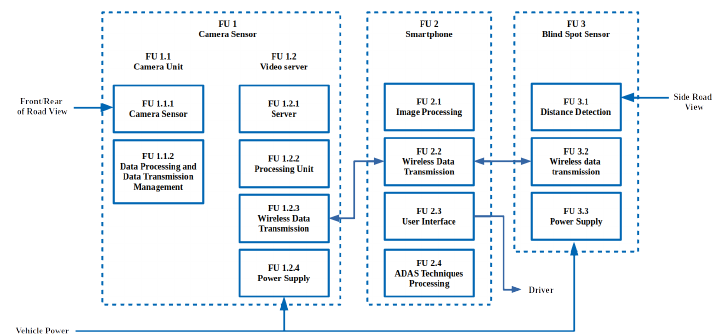
Figure 1. Functional diagram of a proposed wireless ADAS, using a